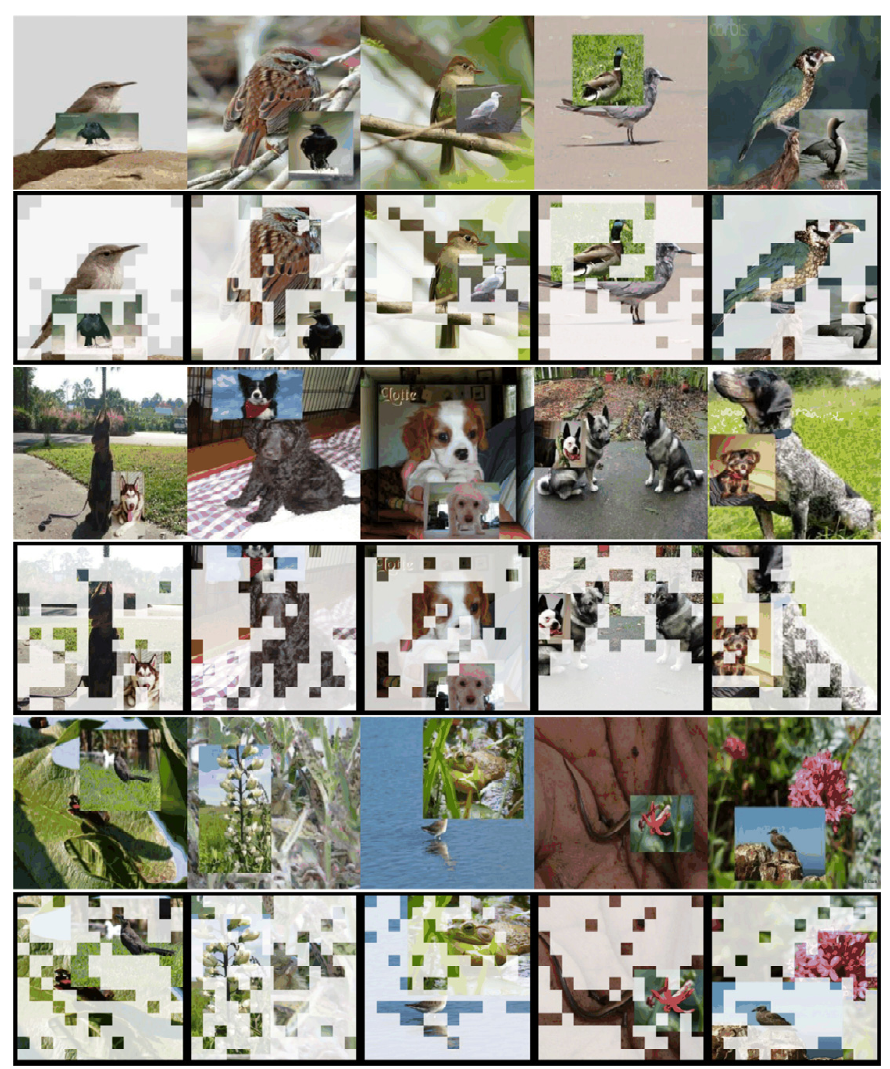
Figure 6. Visualization results of RAMix.